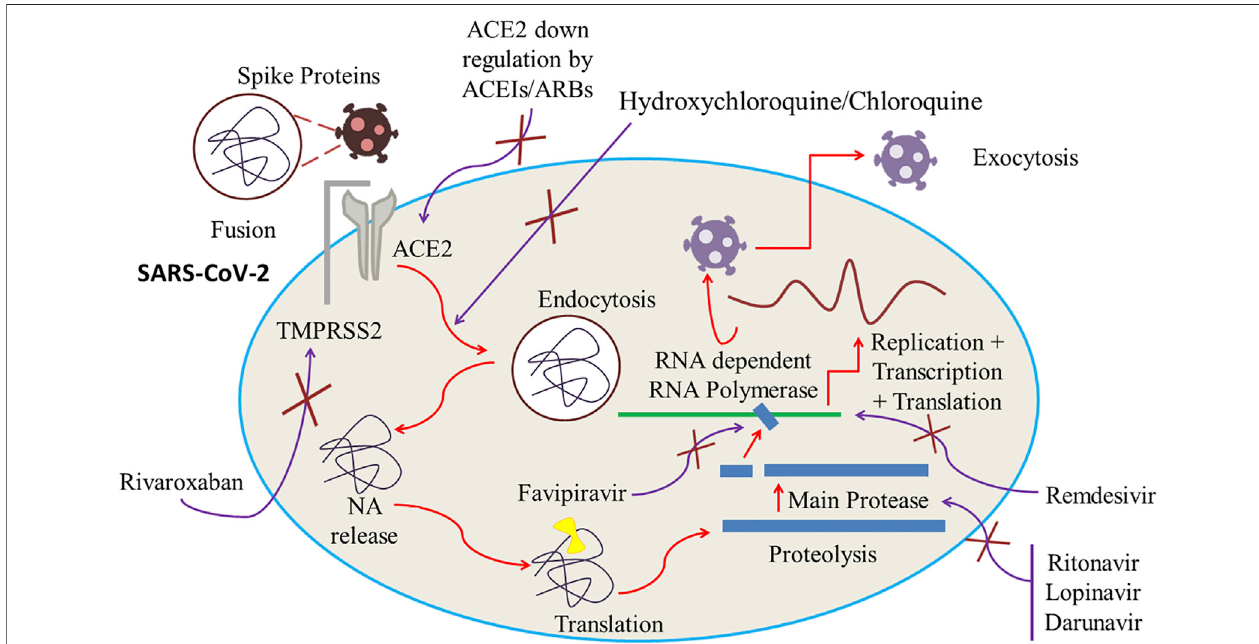
FIGURE 4 | ACE2 downregulation by ACEIs/ARBs. Inhibition of RNA-dependent RNA Polymerase and main protease by, respectively, Favipiravir and Lopinavir/ Ritonavir. Cessation of viral fusion onto the cell membrane and endocytosis by increasing the cell pH by Hydroxychloroquine/Chloroquine. Inhibition of transmembrane protease serine 2 (TMPRSS2) by rivaroxaban which can potentially block the viral entry of SARS-CoV-2 into the host by ceasing the fragmentation of spike protein into the S1 and S2 subunits.